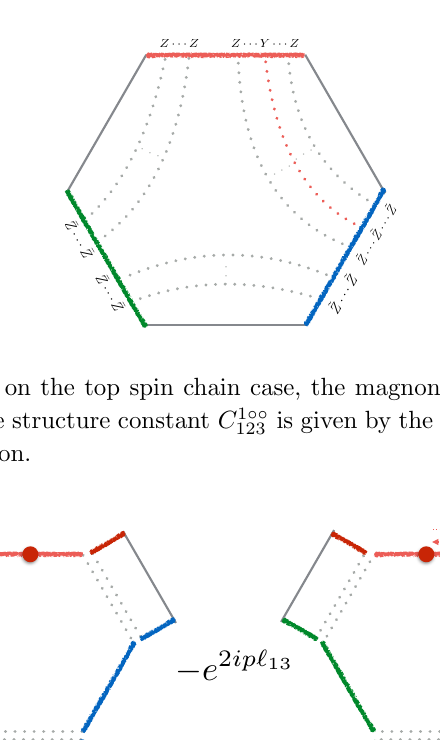
Figure 7 . The (cid:12)rst term is just represented as a magnon on the hexagon. On the other hand, the second term have the propagation factor e 2 ip‘ 13 . This means that (cid:12)rstly a magnon with momentum p move to the left boundary and is re(cid:13)ected at the boundary. Next, the magnon with momentum p move to the splitting point by the propagation factor e (cid:0) ip ( (cid:0) ‘ 13 ) . (cid:0) p p (cid:0) 1 obeys a useful identity where the factor ( p ) ( e (cid:0) i e i 2 2 ) M (cid:17) (cid:0)